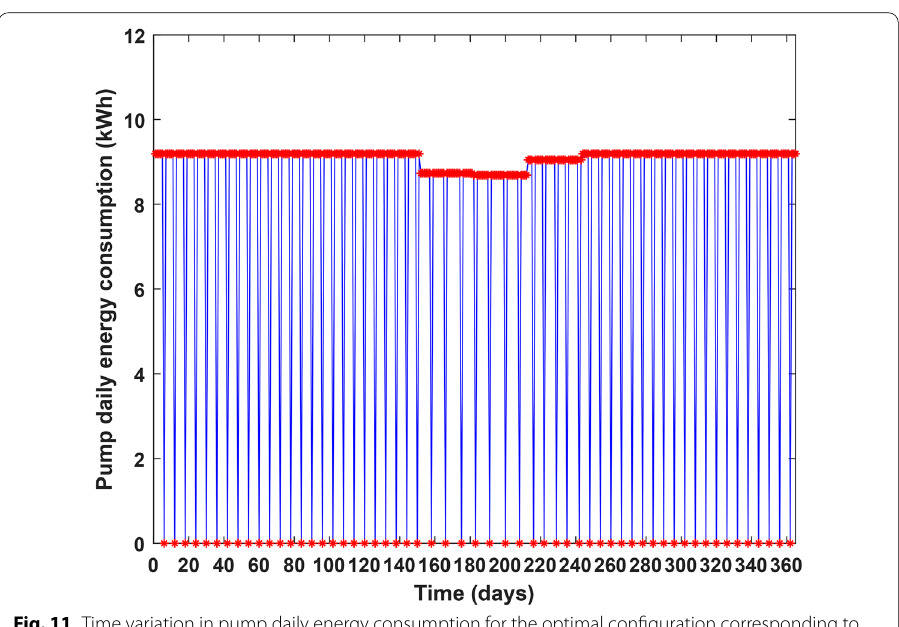
Fig. 11 Time variation in pump daily energy consumption for the optimal configuration corresponding to LWSP of 0%